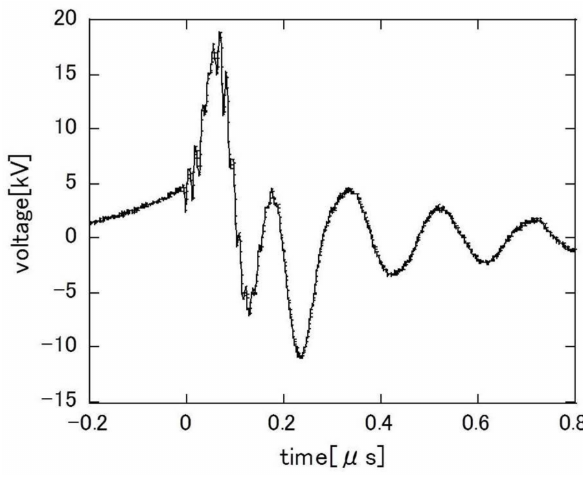
Figure 1. Schematic diagram of experimental apparatus.